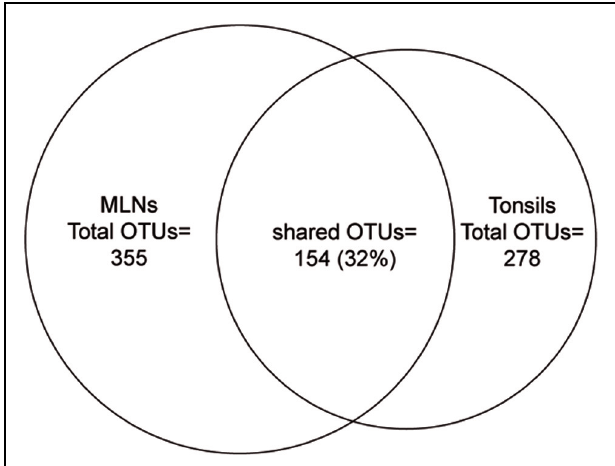
FIGURE 2 | Venn diagram showing the number of shared OTUs between the two sampling sites. The size of the circles is in proportion to the number of OTUs detected in each sampling